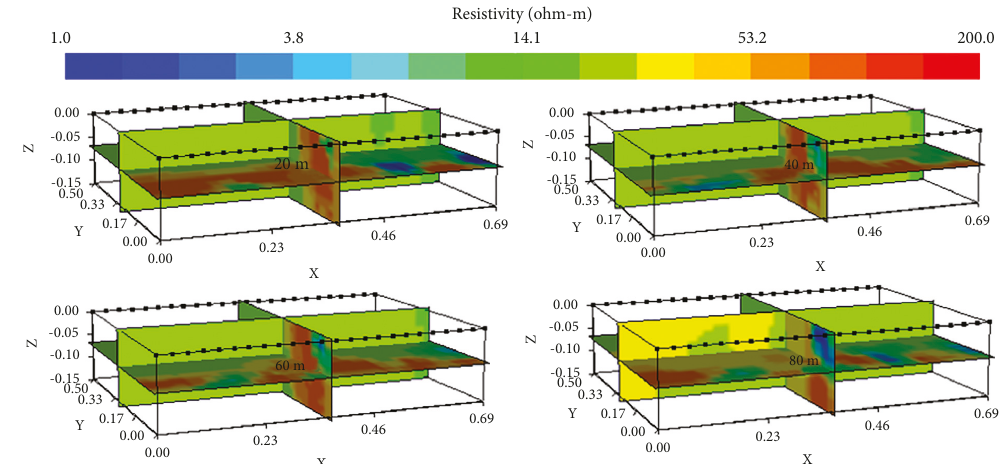
Figure 9: The resistivity section diagram of dynamic at 15cm above the coal seam.